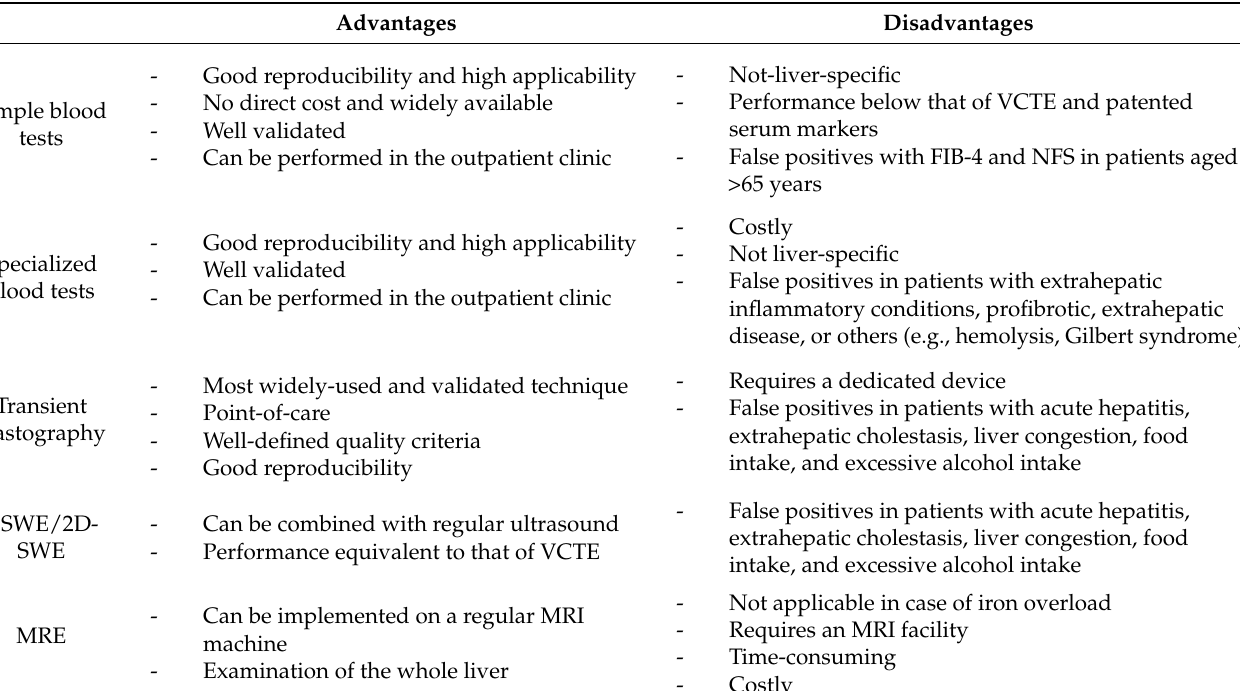
Table 2. Advantages and disadvantages of the main noninvasive liver fibrosis tests from